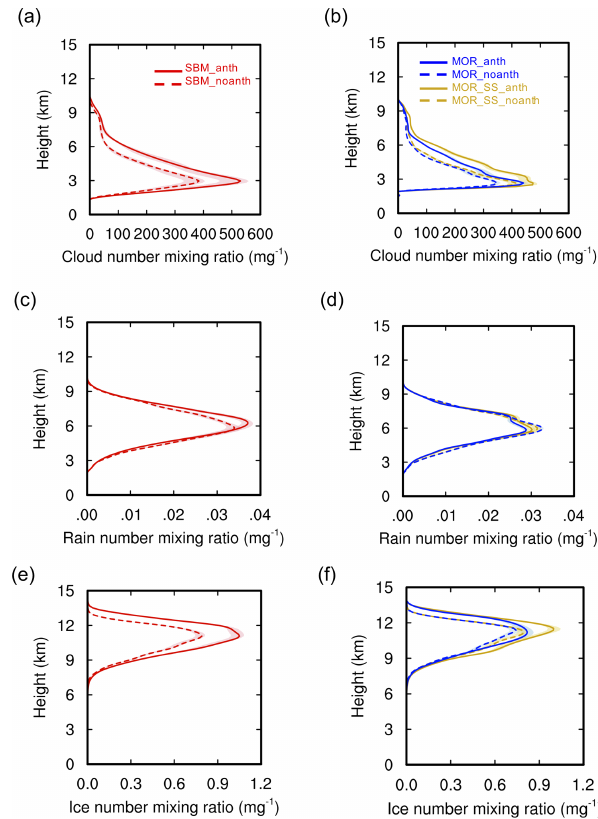
Figure 15. Same as Fig. 14 but for the hydrometeor number mixing